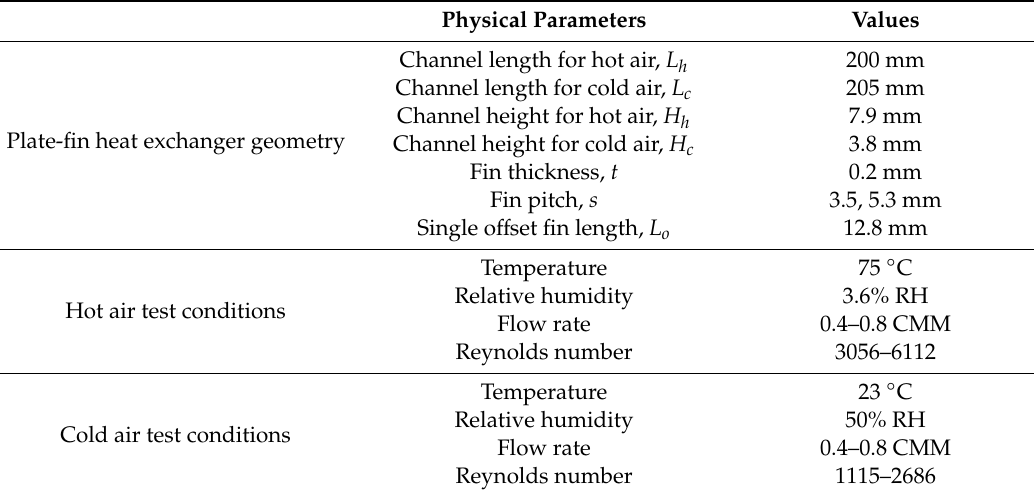
Table 1. Physical parameters and test conditions for evaluating the performance of the plate heat